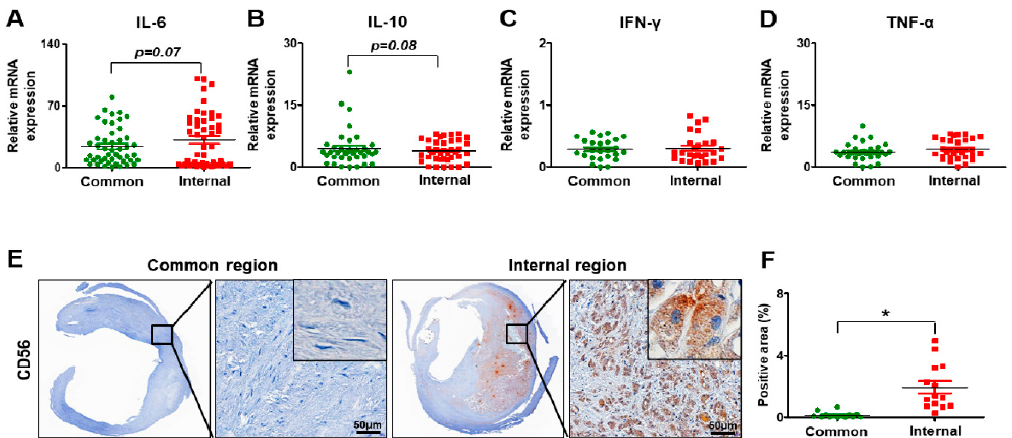
Figure 4. Inflammation in carotid artery stenosis. mRNA expression of interleukin-6 ( A ), interleukin-10 ( B ), interferon-gamma ( C ), and tumor necrosis factor-alpha; ( D ) by qRT-PCR. ( E ) Expression of CD56 by immunohistochemical staining. Scale bar: 50 µ m. ( F ) Quantification of the CD56 positive area. Mean ± SD; * p < 0.05; t -test. Common, common carotid artery; Internal, internal carotid artery; IL-6, interleukin-6; IL-10, interleukin-10; IFN- γ , interferon-gamma; TNF- α , tumor necrosis factor-alpha.